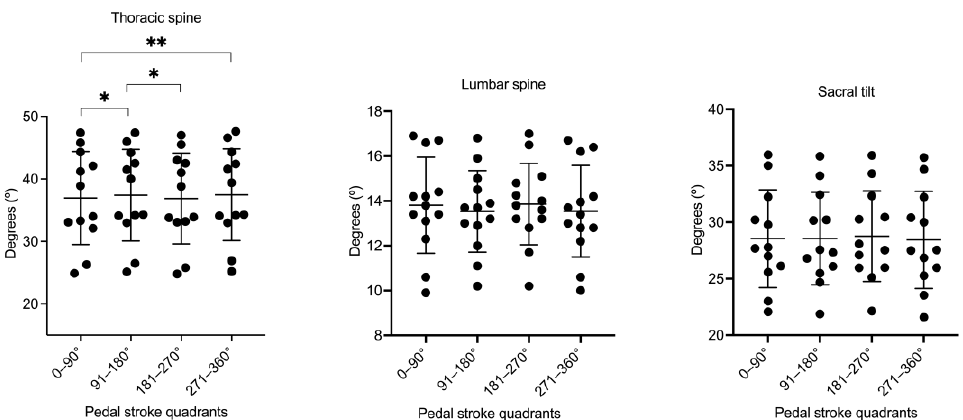
Figure 3. Comparisons of the spinal morphology in each pedal stroke quadrant. The dots represent the mean value at a given quadrant. * p < 0.05; ** p < 0.01.